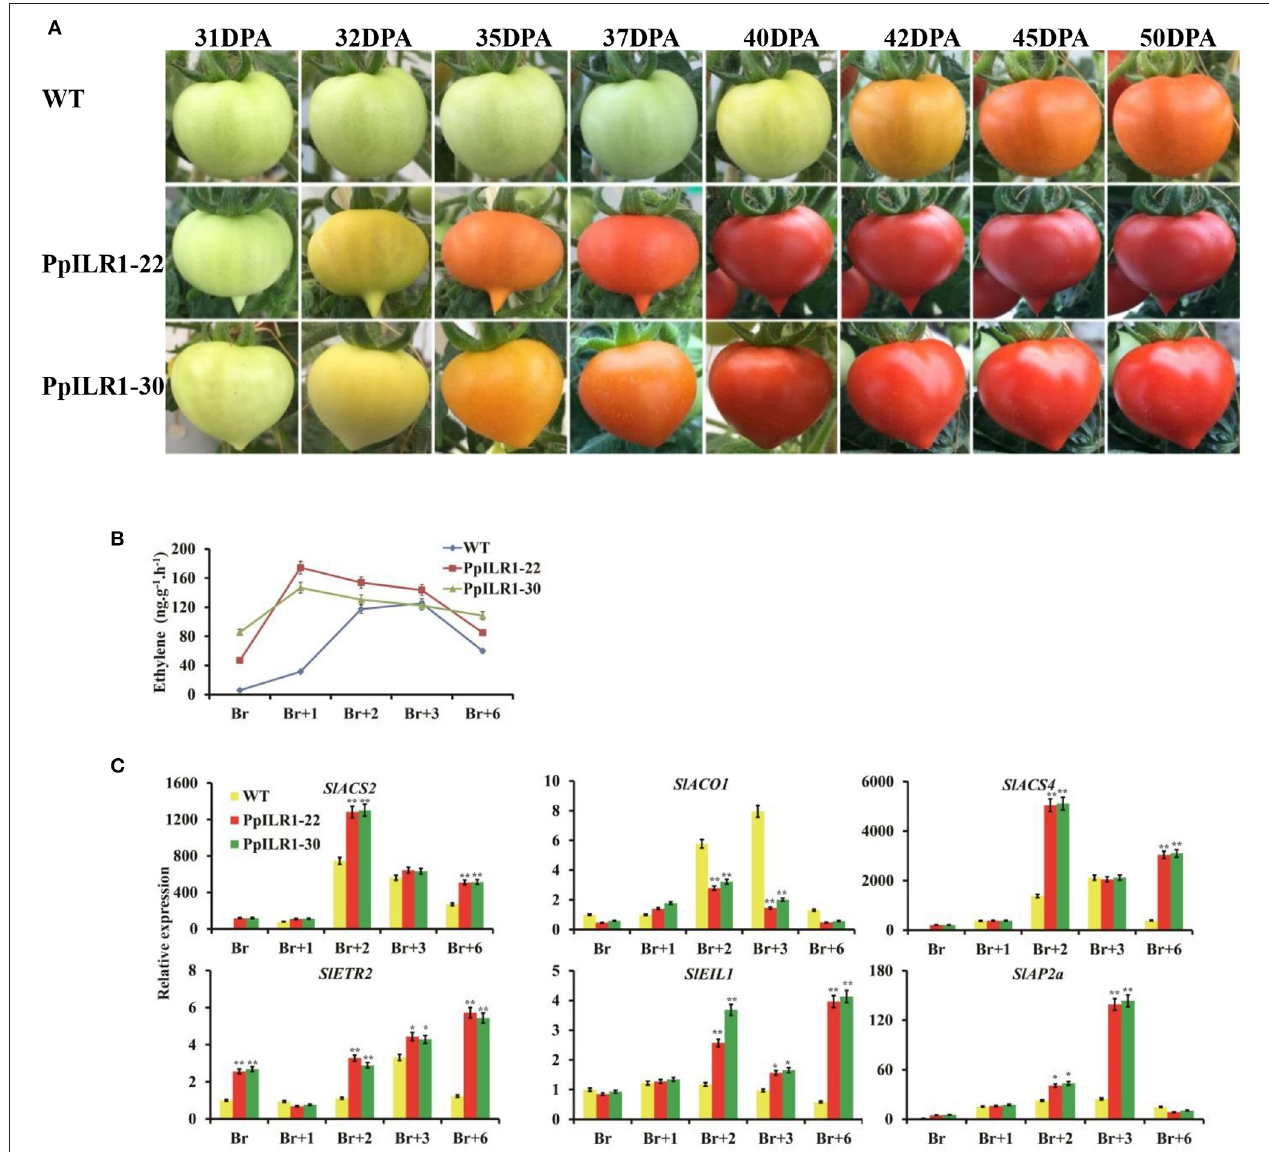
FIGURE 6 | PpILR1 overexpression in tomato accelerates fruit ripening. (A) Accelerated fruit ripening in two tomato transgenic lines, PpILR1-22 and PpILR1-30, compared with the WT. (B) Ethylene production in PpILR1-22, PpILR1-30, and the WT control. (C) Expression analysis of ethylene biosynthesis- and fruit ripening-related genes in PpILR1-22, PpILR1-30, and WT control fruit by qRT-PCR. Values represent the mean ± standard deviation of three biological replicates. Asterisks indicate significant differences between the WT and transgenic lines (* P < 0.05, ** P < 0.01; Student’s t -test).